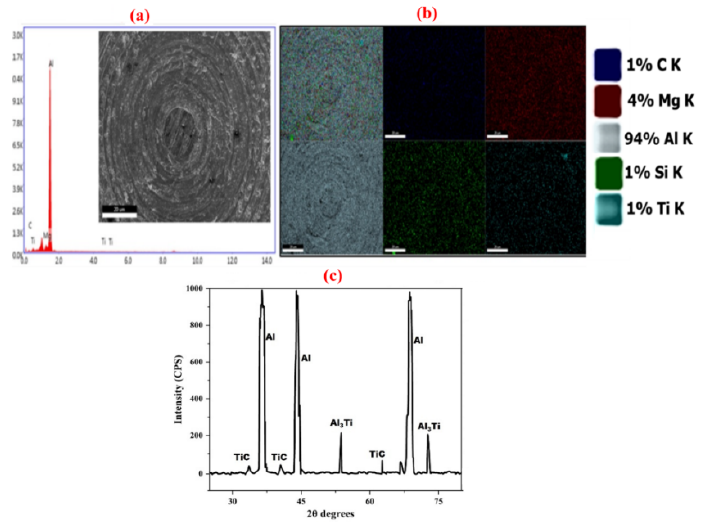
Figure 1. ( a ) SEM image, along with EDS analysis; ( b ) the corresponding elemental mapping using the RUSK model of Al6061-TiC MMC sample; and ( c ) XRD analysis results of Al6061-TIC